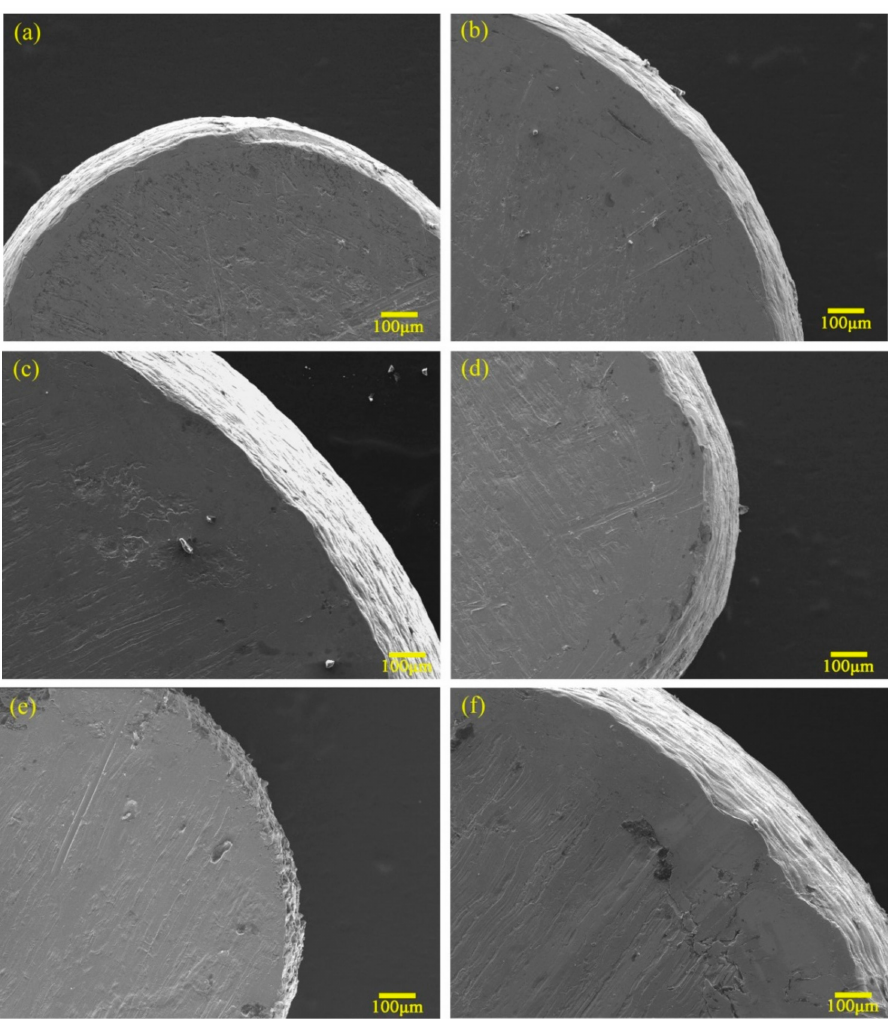
Figure 4. Surface morphology of compressed samples with various sample sizes and various grain sizes (compression degrees are all 60%): ( a ) Ø0.8 mm × 1.2 mm and grain size 15 µ m; ( b ) Ø1 mm × 1.5 mm and grain size 15 µ m; ( c ) Ø2 mm × 3 mm and grain size 15 µ m; ( d ) Ø0.8 mm × 1.2 mm and grain size 30 µ m; ( e ) Ø0.8 mm × 1.2 mm and grain size 50 µ m; ( f ) Ø2 mm × 3 mm and grain size 50 µ